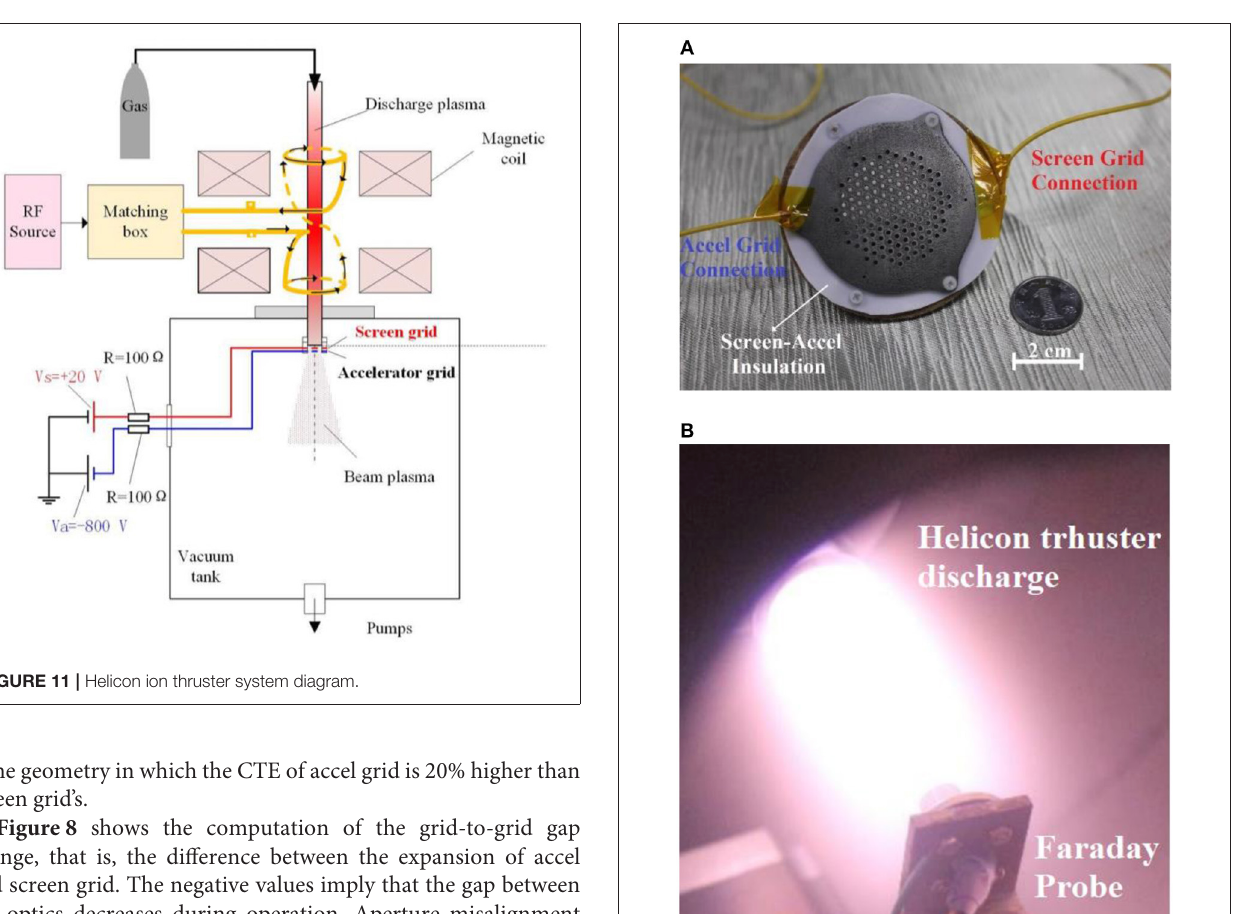
A simple stainless-steel discharge chamber with